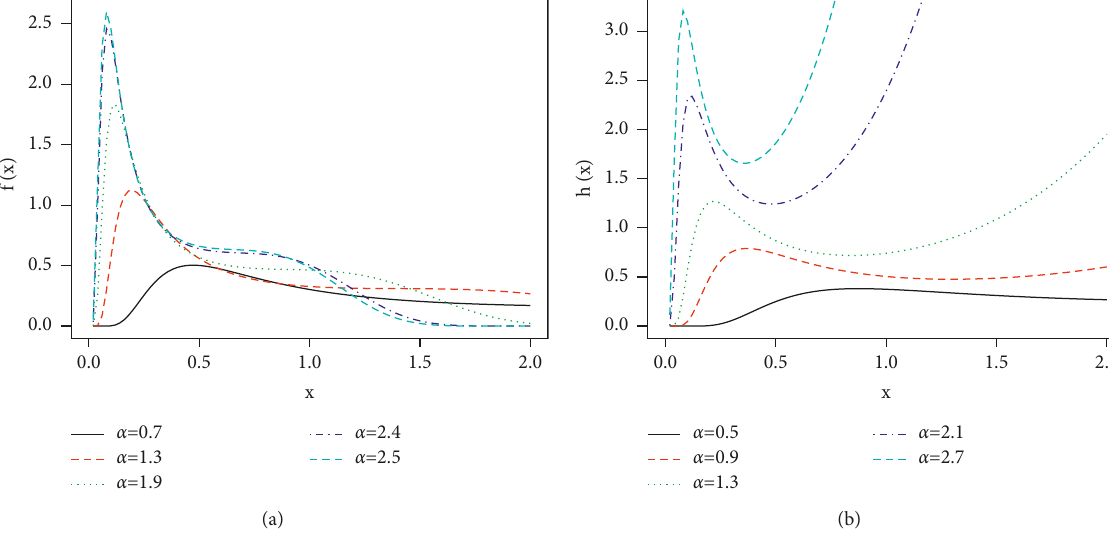
Figure 2: Graphical representation for the plots of the LCLi: (a) density and (b) hazard rate using certain values of the